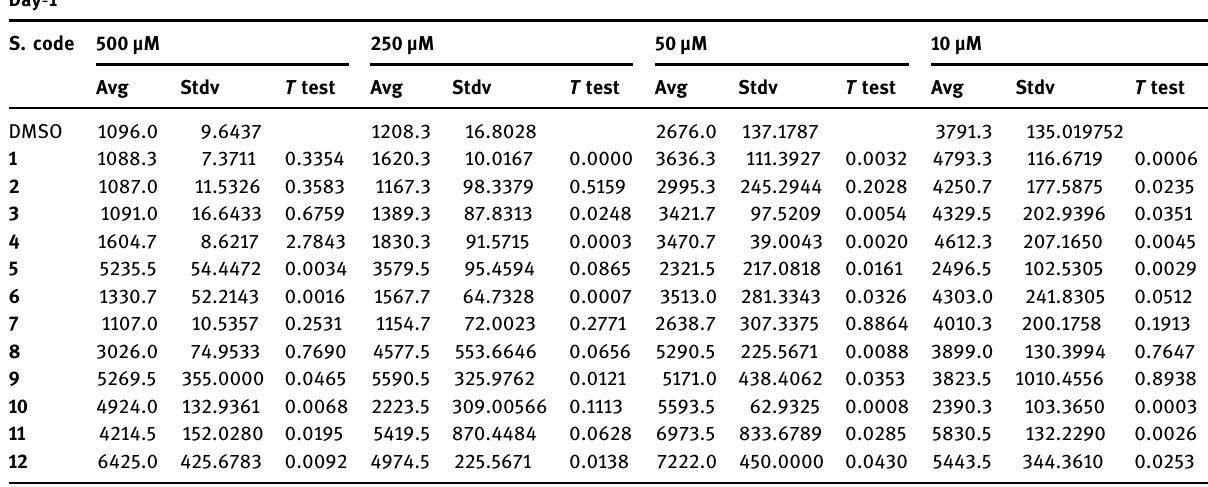
Table 1: Proliferation data for day